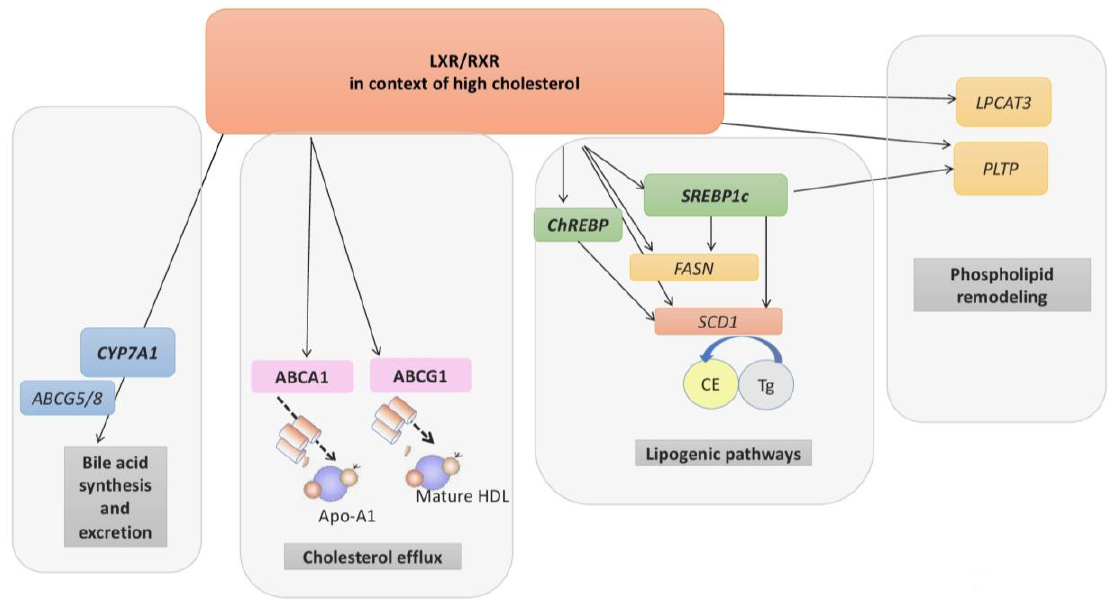
Figure 1. The roles of LXRs in lipid metabolism. LXRs regulate hepatic cholesterol elimination by upregulating CYP7A1 as well as excreting cholesterol via ATP binding cassette transporters ABCG5/8